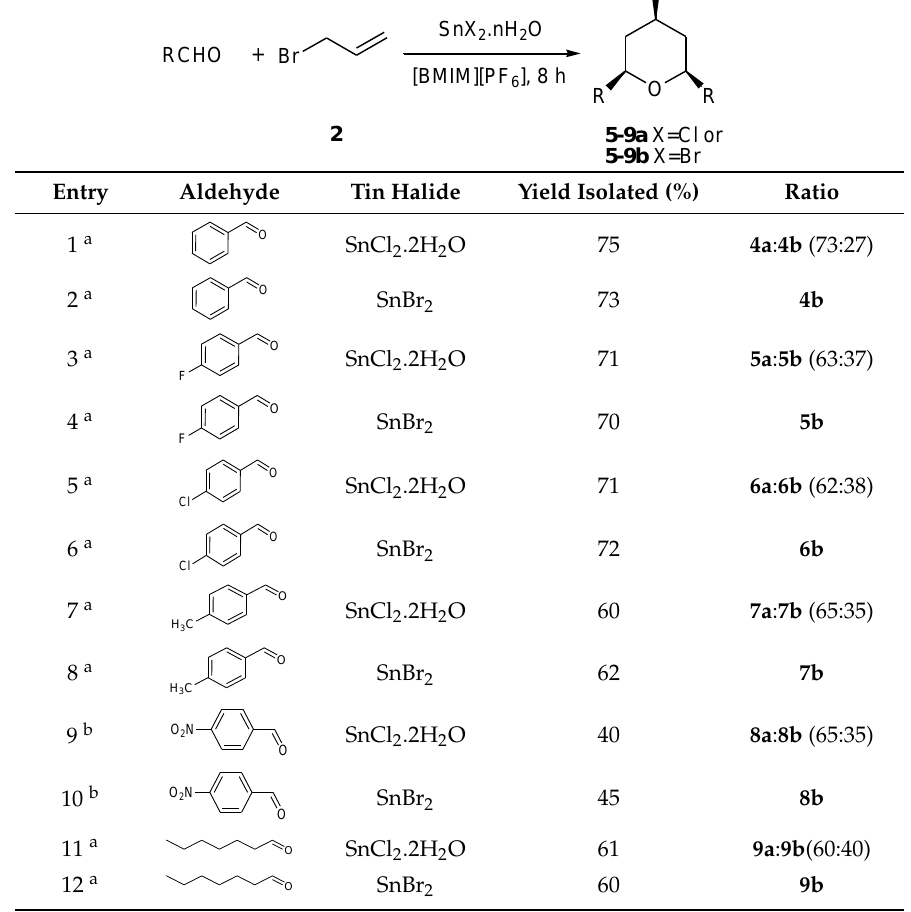
Table 4. Synthesis of several Tetrahydropyrans (THPs) varying tin halides promoted by [BMIM][PF 6 ].